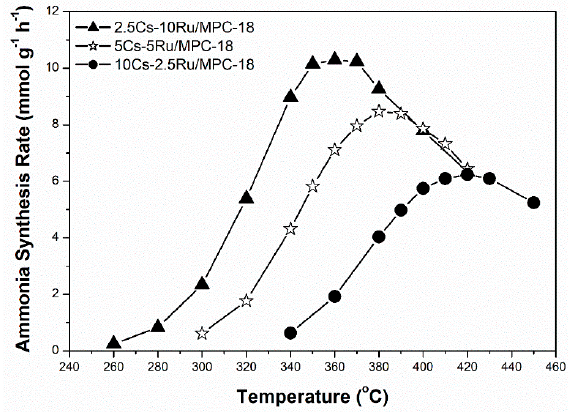
Figure 7. Rate of ammonia synthesis as a function of Ru loading over Cs-Ru / MPC-18 Figure 7 . Rate of ammonia synthesis as a function of Ru loading over Cs-Ru/MPC-18 catalysts.